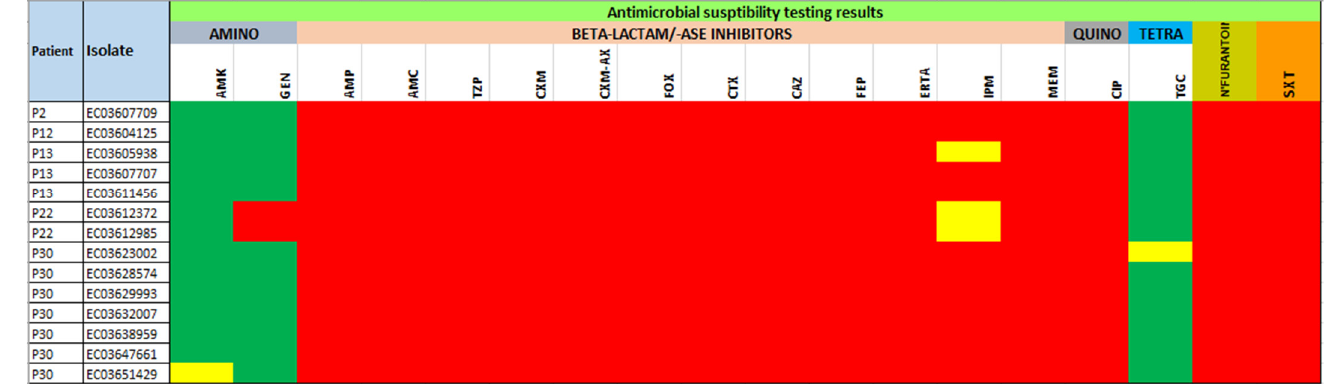
Figure 1. Antibiotic susceptibility patterns of CPKP isolates ( n = 14). Antibiotic susceptibility profiles are shown for the fourteen sequenced K. pneumonia isolates. Antibiotic resistance is displayed in red, intermediate resistance is displayed in yellow, and susceptibility is displayed in green.